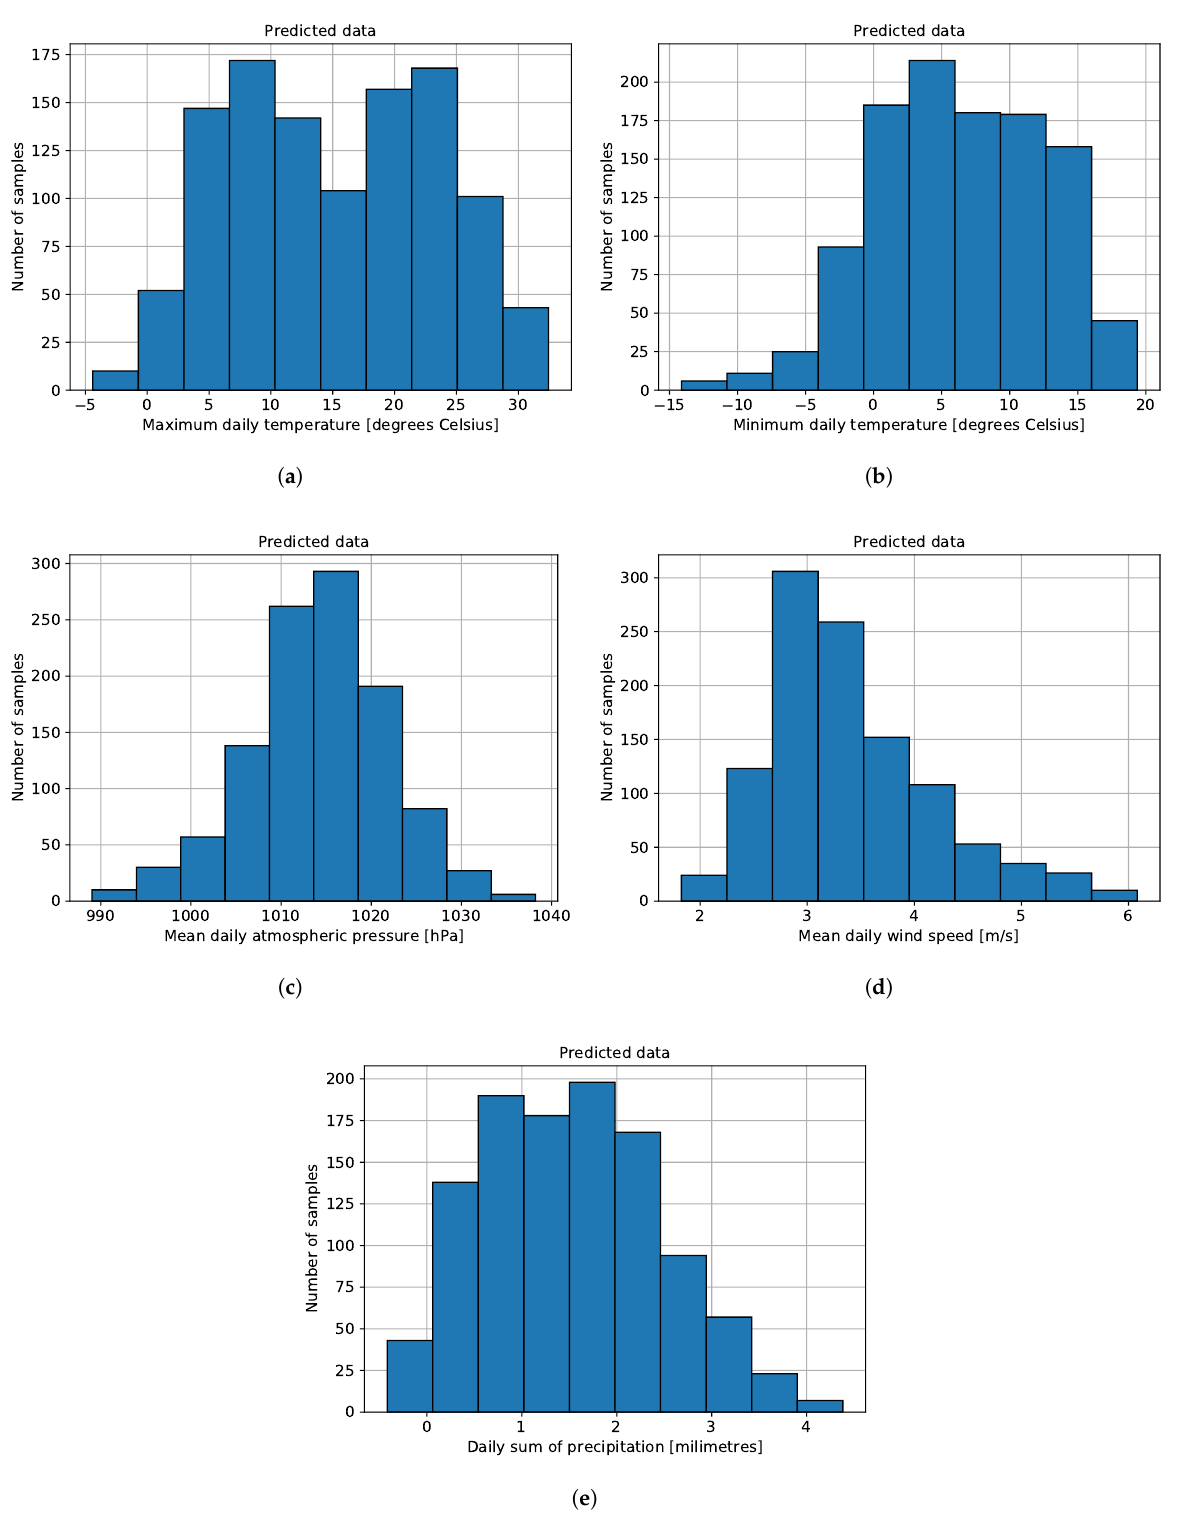
Figure A5. Output data histograms (the maximum ( a ) and minimum ( b ) daily temperature, mean daily atmospheric pressure ( c ), mean daily wind speed ( d ), and daily sum of precipitation ( e